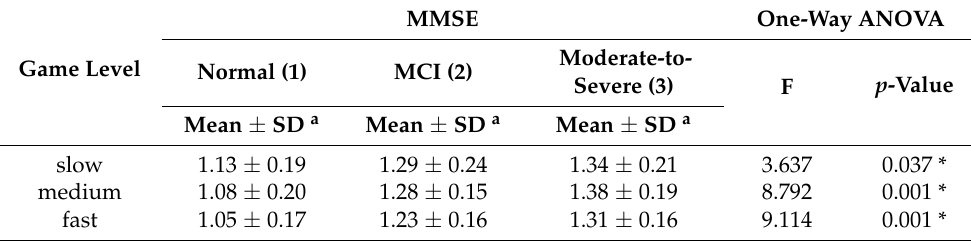
Table 7. Time-unlimited mode: posterior comparison of each group of MMSE at different game speeds. MMSE One-Way ANOVA Game Level Normal